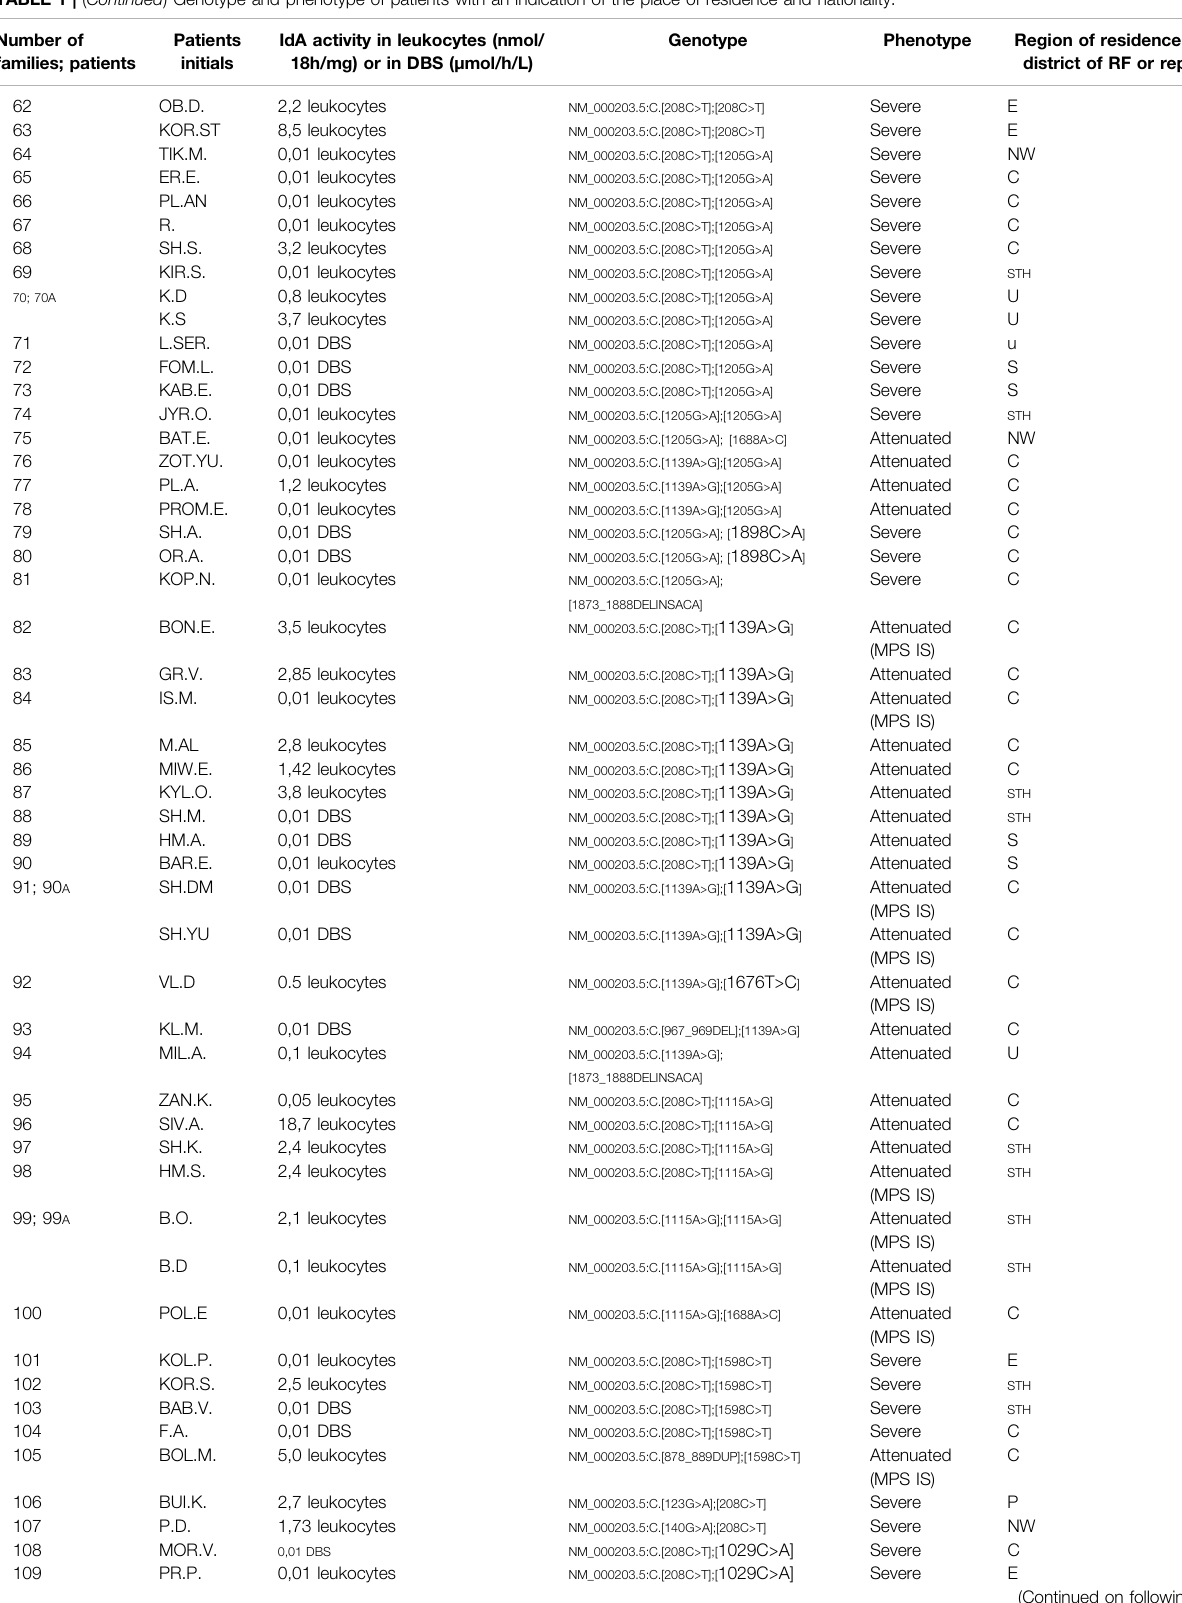
TABLE 1 | ( Continued ) Genotype and phenotype of patients with an indication of the place of residence and nationality. Number of families;